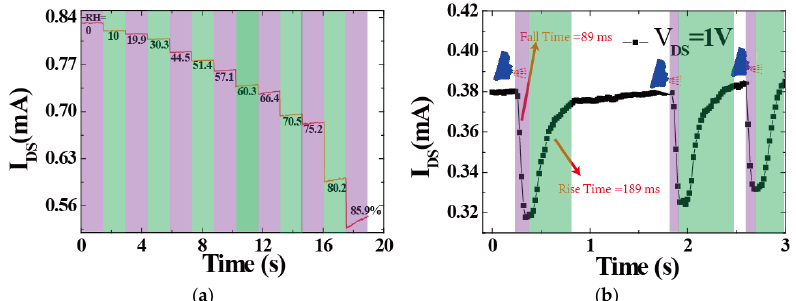
Figure 3. ( a ) Channel current response measurement of the 3DGF humidity sensor with varying different RH. ( b ) Response and recovery times of the device at 85% RH and the drain voltage was fixed at 1 V.